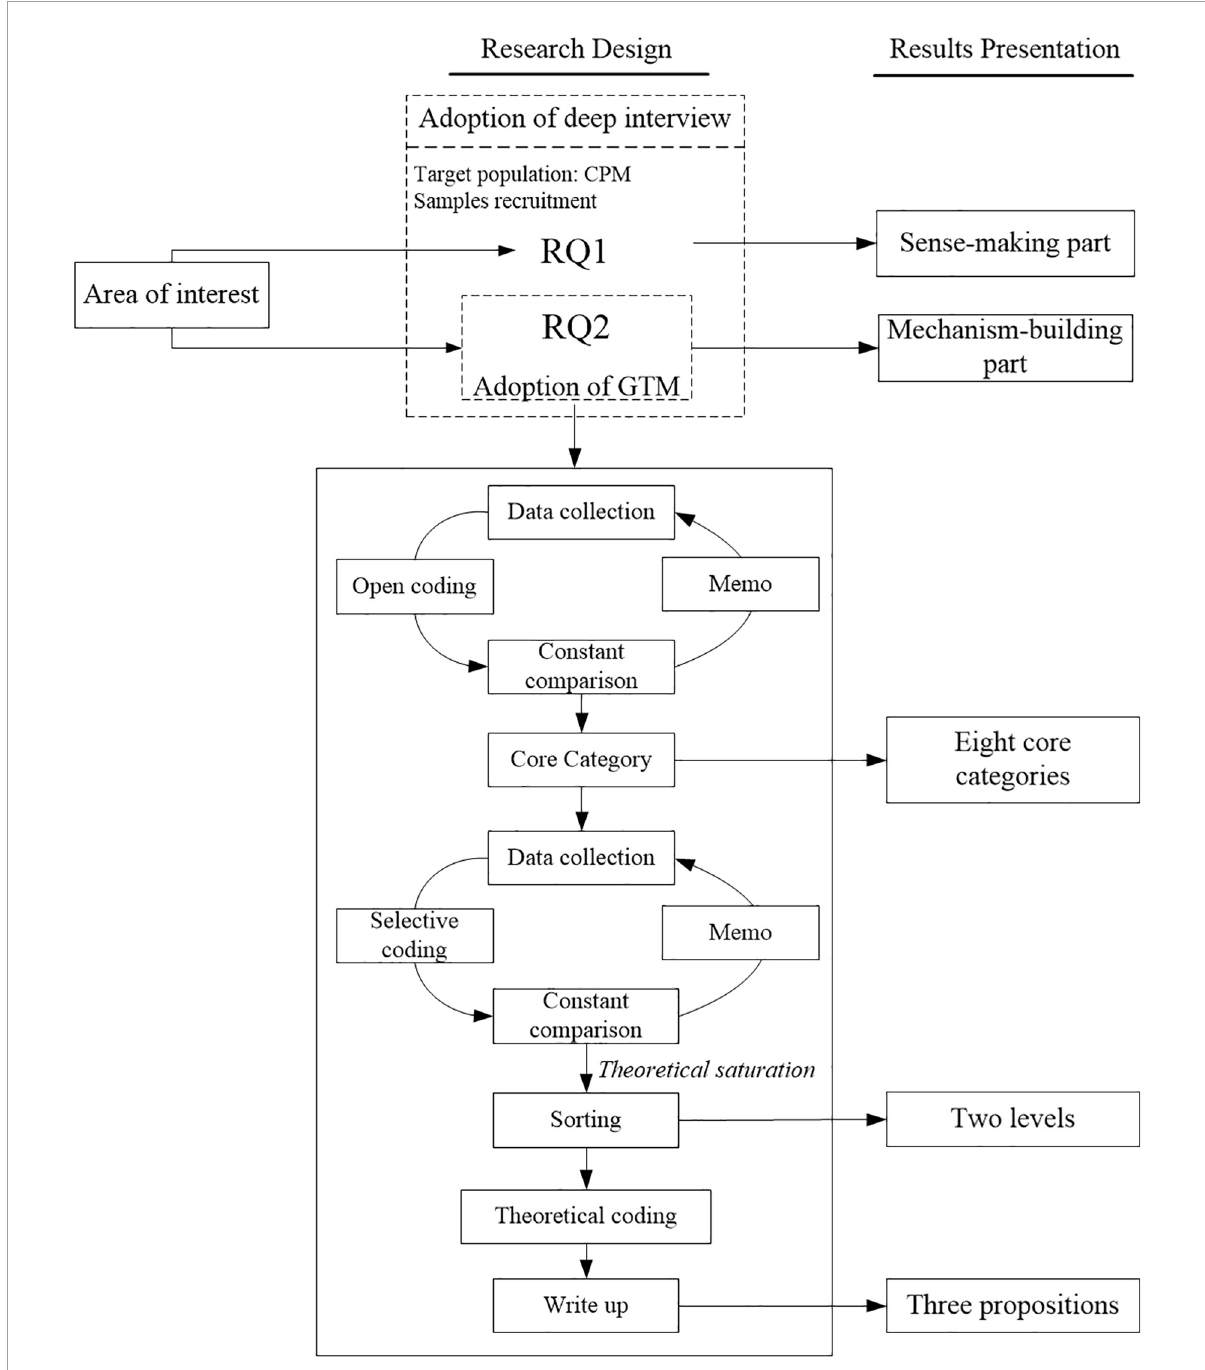
FIGURE1 Research design of the current study.